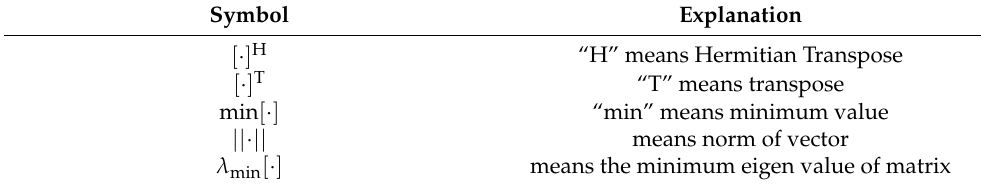
Table 1. Frequently used symbols.